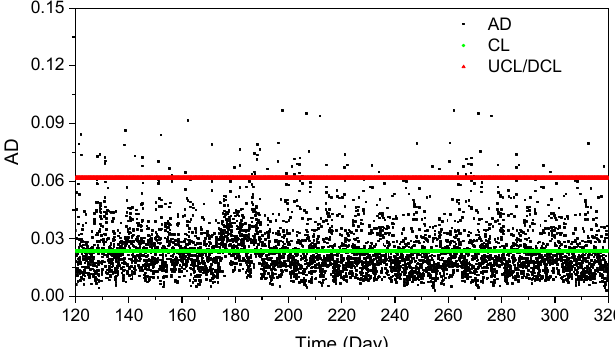
Figure 22. The abnormal detector, CL , UCL and DCL during operational conditions.